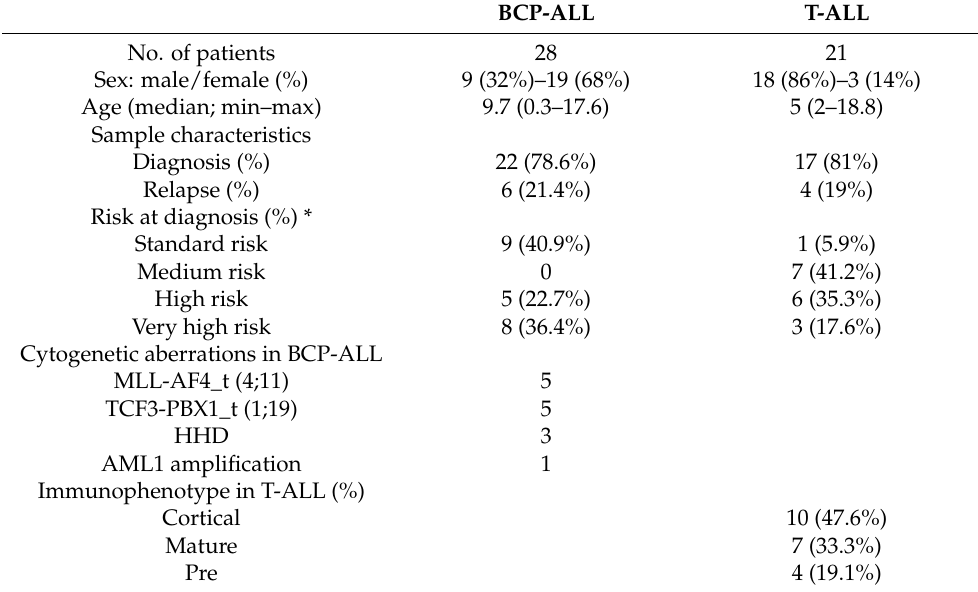
Table 1. Characteristics of patients included in the study, for which proteasome activity was assessed by activity-based probes profiling. MLL-AF4: chimeric protein of mixed-lineage leukemia (MLL)-AF4, TCF3-PBX1: fusion protein of transcription factor 3 and PBX homeobox 1, HHD: high